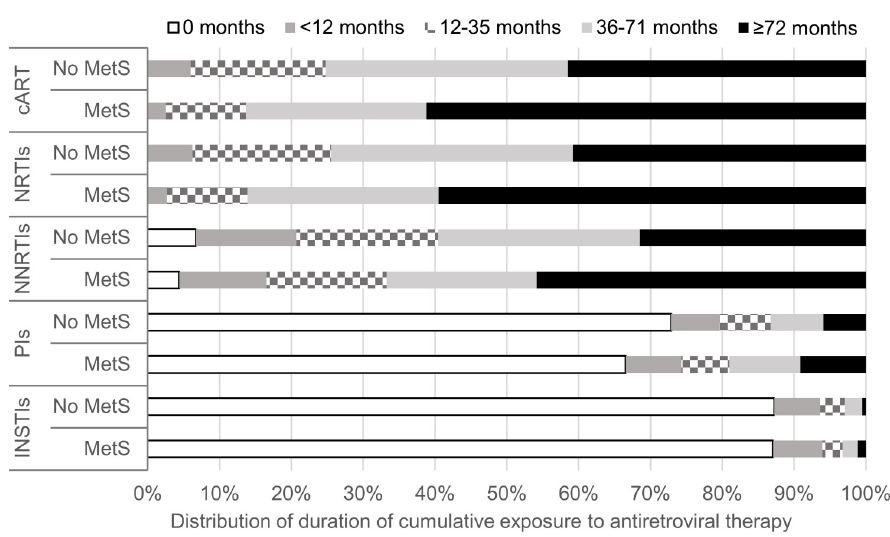
Fig 3. Distribution of duration of cumulative exposure to combination antiretroviral therapy by status of metabolic syndrome and drug class among people living with HIV on follow-up between 2015 and 2017. cART, combination antiretroviral therapy; INSTIs, integrase strand transfer inhibitors; MetS, metabolic syndrome; NNRTIs, non-nucleoside reverse transcriptase inhibitors; NRTIs, nucleoside reverse transcriptase inhibitors; PIs, protease